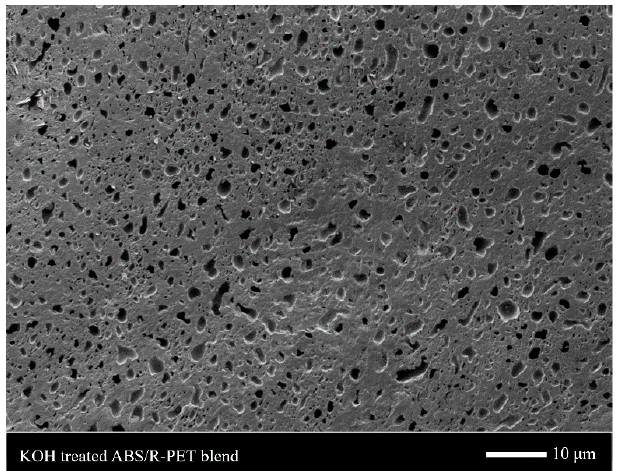
Figure 1. The SEM image of ABS/R-PET (acrylonitrile-butadiene-styrene/recycled polyethylene terephthalate) blend treated with KOH/ethanol solution. The small pores that were dispersed in the ABS/R-PET domain were formed by etching the R-PET.